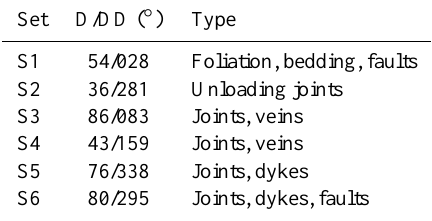
Table 1. Summary of interpreted discontinuity